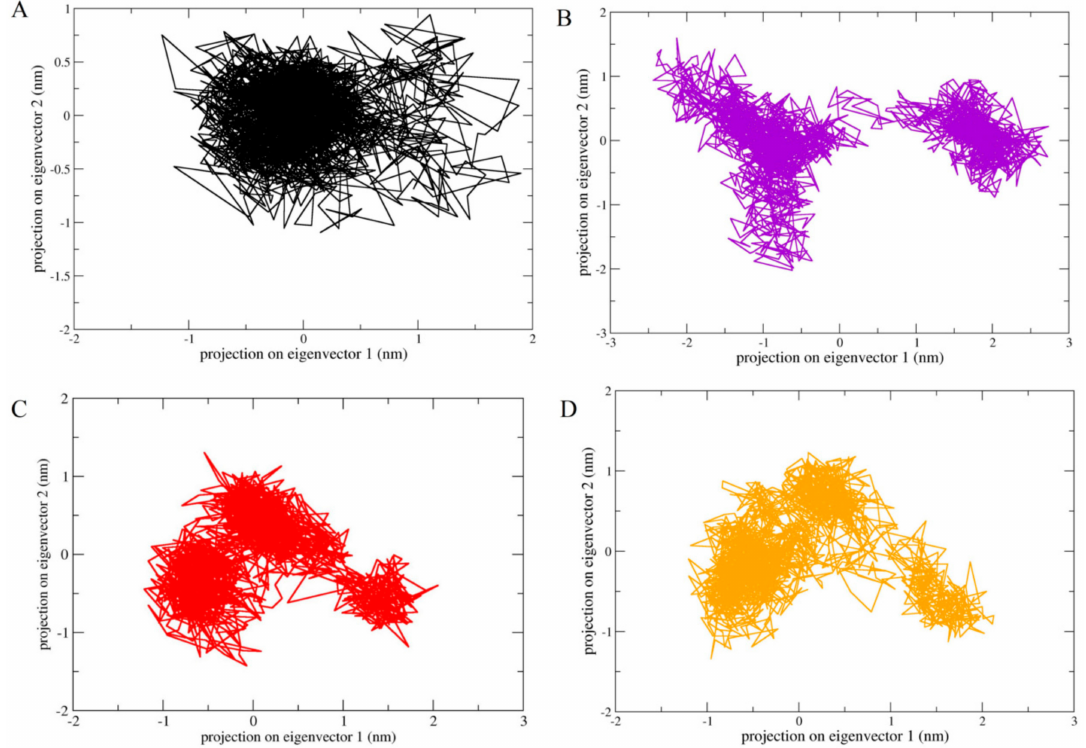
Figure 6. Two-dimensional projection of motion of trajectory of MDM2 bound with hits over the PC1 and PC2. ( A ) Reference, ( B ) 3- trans - p -coumaroyl maslinic acid, ( C ) Silvestrol and ( D ) Betulonic